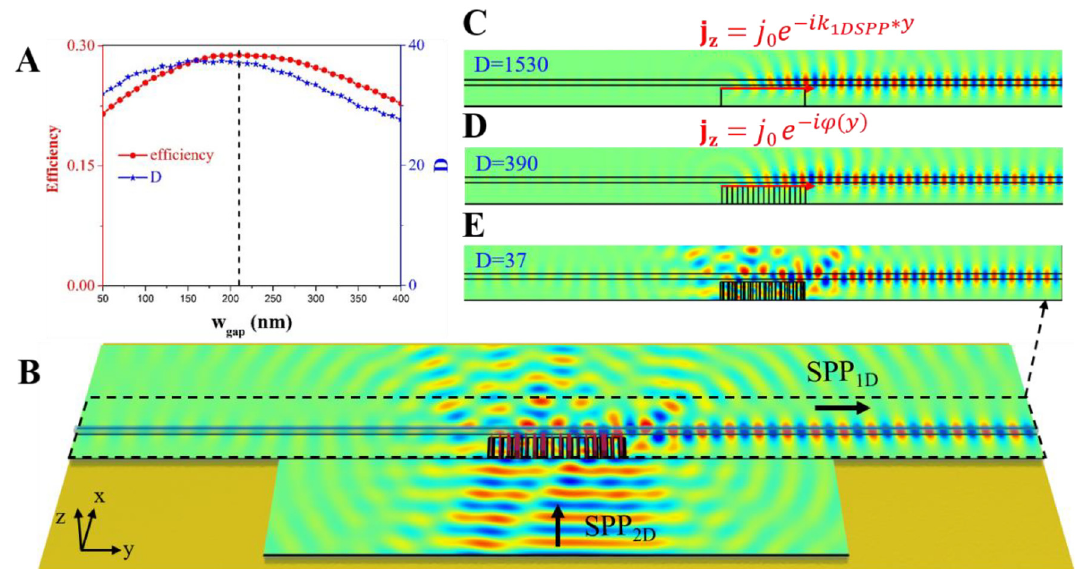
Figure 3: Demonstration of the directional router of trans-dimensional SPP based on phase-gradient meta-wall. (A) The directional coupling efficiencyanddirectivityoftheSPProuterversusthewidth w gap ofgapbetweenthemeta-wallandtheplasmonicwaveguide(B)FEM-simulated near- fi eld E z pattern on a plane above the plasmonic metal for a SPP Gaussian beam striking the meta-wall with the phase gradient ξ = k 1 DSPP . The 1D SPP eigenmode of the plasmonic waveguide can be excited under the cases of the continuous current element model (C), the discrete current element model (D) and the meta-wall based on real structure